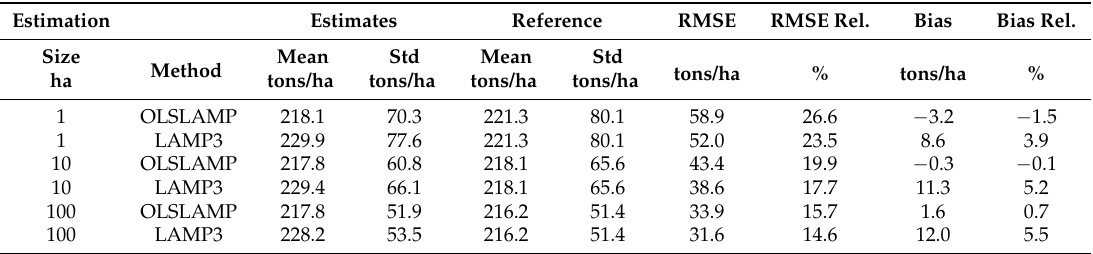
Table A2. Error statistics for the comparison of LAMP3 estimates of above-ground biomass before and after histogram matching against LiDAR estimates, at different